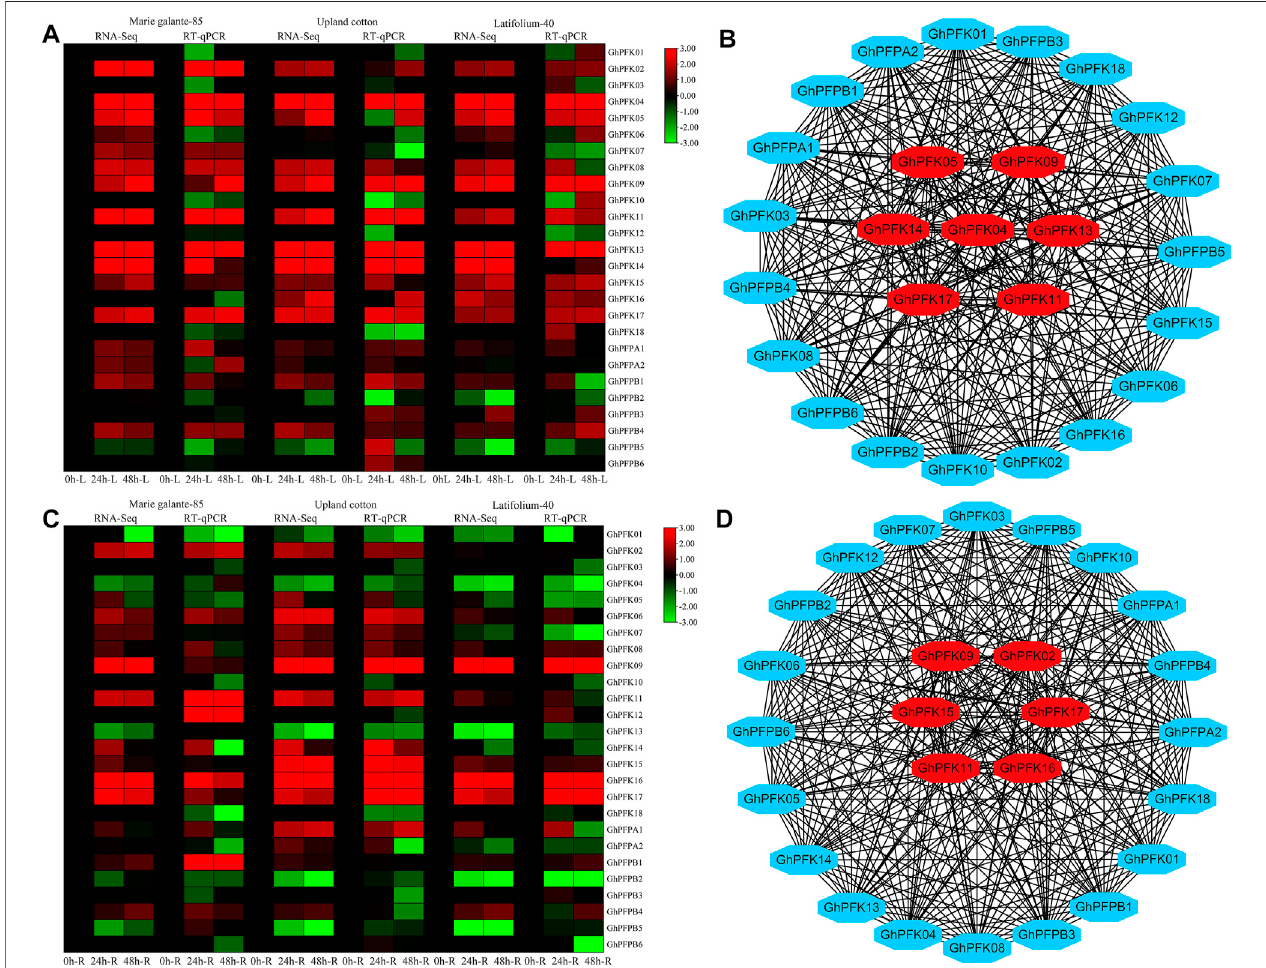
FIGURE8| RNA-seq,RT-qPCR,and Co-expression networkanalysisofPFKgenes. (A) . RNA-seq and RT-qPCRexpression analysisofthePFKgenesinthe leaf tissue of G. hirsutum races; (B) . Co-expression analysis and hub gene identi fi cation from leaf expression; (C) . RNA-seq and RT-qPCR expression analysis of the PFK genes in the root tissue of G. hirsutum races; (D) . Co-expression analysis and hub gene identi fi cation from leaf expression. Genes in the center of the network analysis with red color are hub genes.